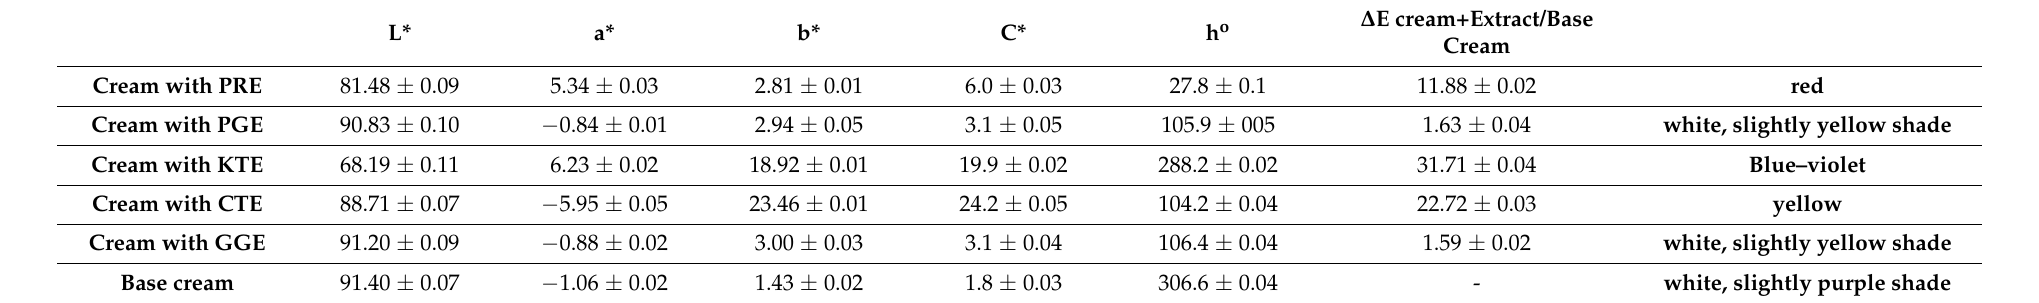
Table 4. Color parameters for cosmetic creams with water–ethanol extracts: P. rhoeas L. (PRE), P. granatum L. (PGE) , C. ternatea L. (KTE), C. tinctorius L. (CTE) , G. globasa L. (GGE). Values are means of three replicate determinations ( n = 3) ±